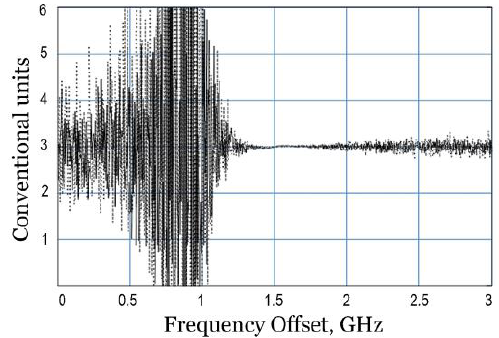
Fig. 2. Fulfillment of the criterions (10) for UB-ODSB-radiation fall into the frequency range of the ODUT.